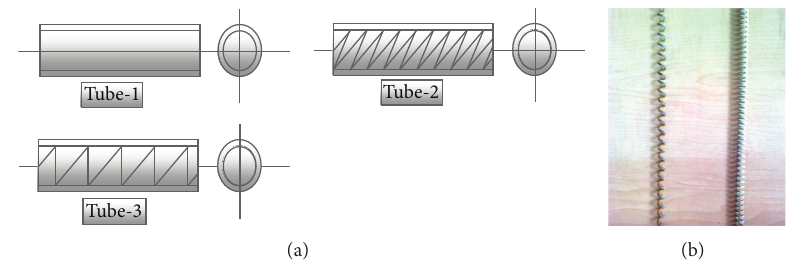
F 3: (a) Heat transfer surface augmentation elements, (b) the pictures of the elements.